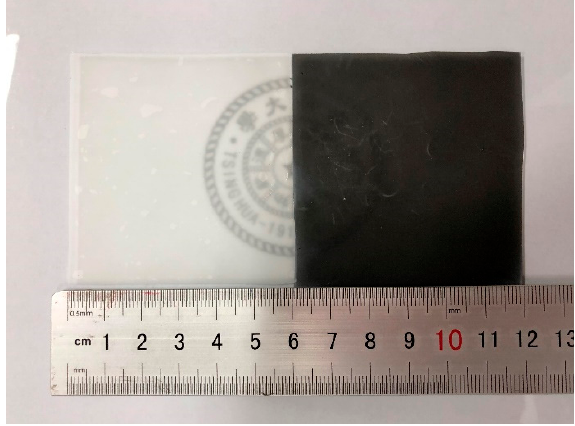
Figure 1. Digital photo of the PVDF nanoporous membrane and the PVDF / G-0.15 membrane.